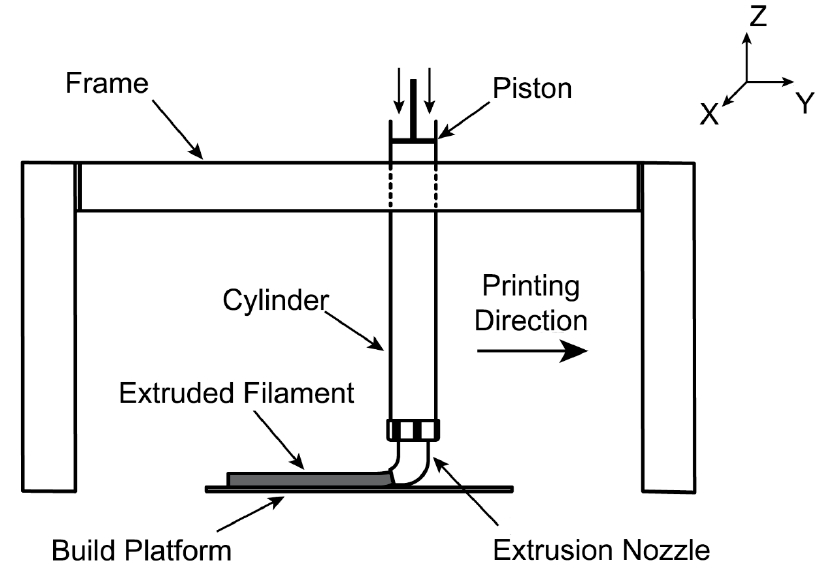
Figure 2. Schematic drawing of the custom-made 3D printing apparatus.